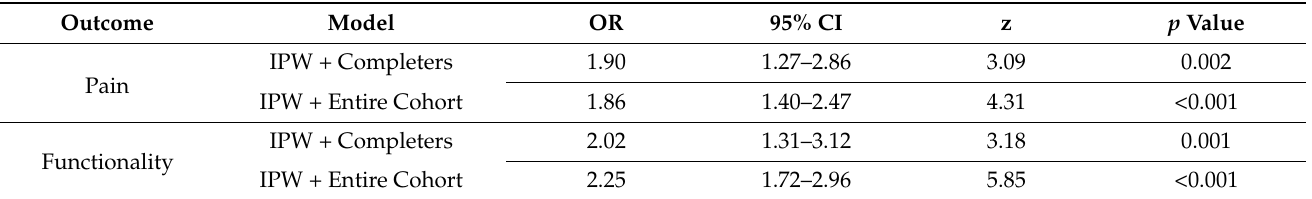
Table 3. Odds ratio (OR) for being a responder for pain and functionality for the intervention group, and applying inverse probability weighting (IPW), considering both completers and entire